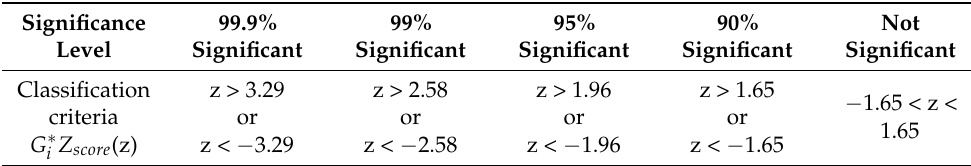
Table 3. Classification criteria of local spatial aggregations of